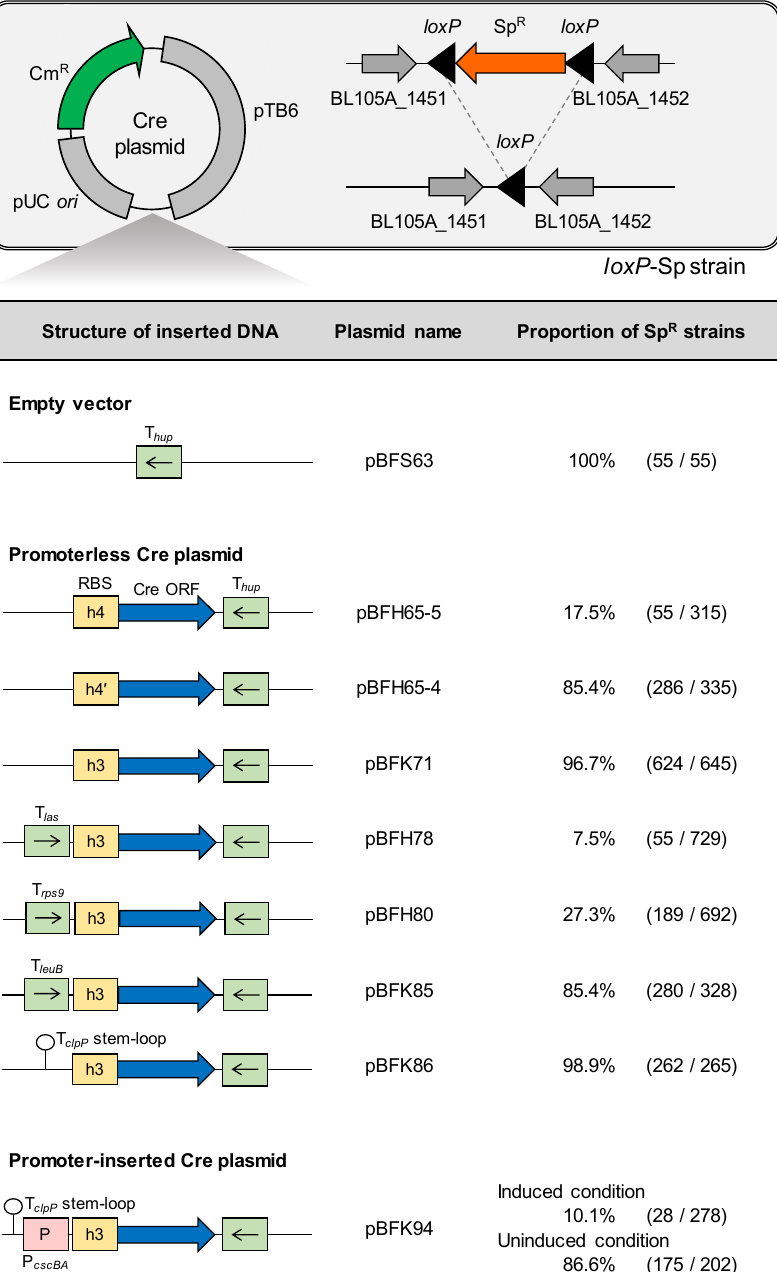
Figure 2. Proportion of Sp R strains when each Cre expression plasmid was independently introduced into the loxP -Sp strain. Detailed methods are described in Section 2.5 of the Materials and Methods. The proportion of Sp R strains in the tested strains is shown as a percentage. The values in parenthesis indicate the number of Sp R strains among the tested strains. Sp R , spectinomycin resistance; Cm R , chloramphenicol resistance. Green box with an arrow, terminator; yellow box, ribosome-binding site (RBS); pink box, promoter.